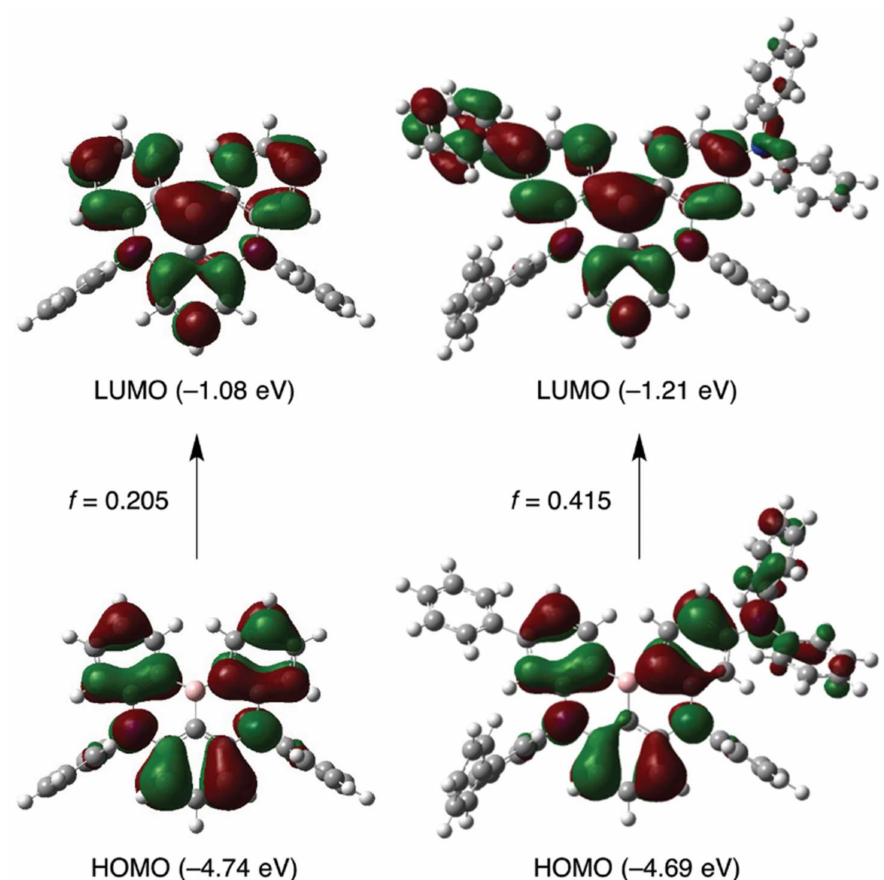
Figure 8. Orbital localization and highest occupied molecular orbital (HOMO) lowest unoccupied molecular orbital (LUMO) energies of DABNA-1 ( left ) and DABNA-2 ( right ) calculated at the B3LYP/6–31G(d) level. Figure reproduced with permission from Hatakeyama et al. [95] (reproduced with permission from [95] Copyright Wiley-VCH,